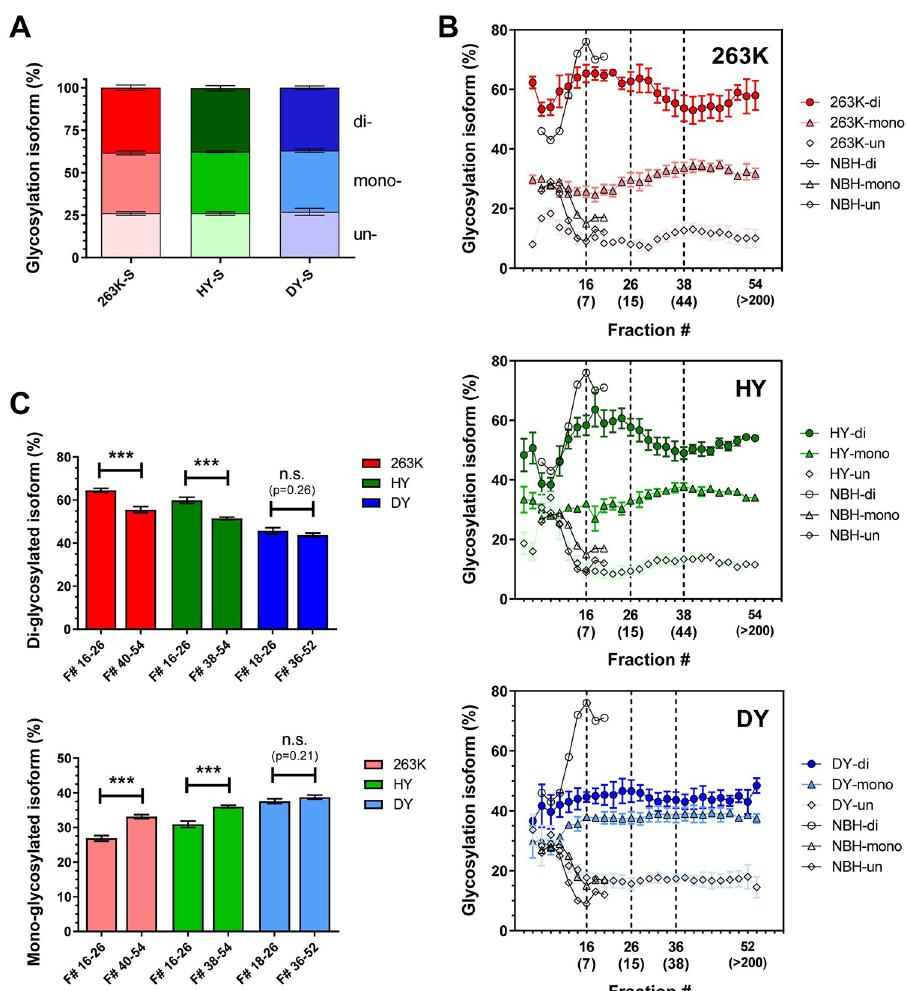
Fig 3. Percentage of PrP glycosylation isoforms among AF4 fractions for 263K (red), HY (green) and DY (blue). A) Percentage of di-, mono-, and un-glycosylated PrP present in detergent-solubilized BHs as calculated from immunoblots of three BHs for each strain (representative immunoblot depicted in Fig 1C). B) Percentage of di- (circles), mono- (triangles), and un-glycosylated (rhombus) PrP isoforms present in each AF4 fraction as calculated from NBH (empty symbols), 263K (red), HY (green), and DY (blue) immunoblots of three BHs for each strain (representative immunoblot shown in Fig 2B). The R h (nm) of particles contained in fractions 16, 26, 36/38, and 52/54 are indicated in brackets. C) Percentage (average ± SE) of di- (top) and mono-glycosylated (bottom) PrP isoforms in the range of fractions where the glycoform ratio remains constant. Three BHs were analyzed for each prion strain. p- value ��� �